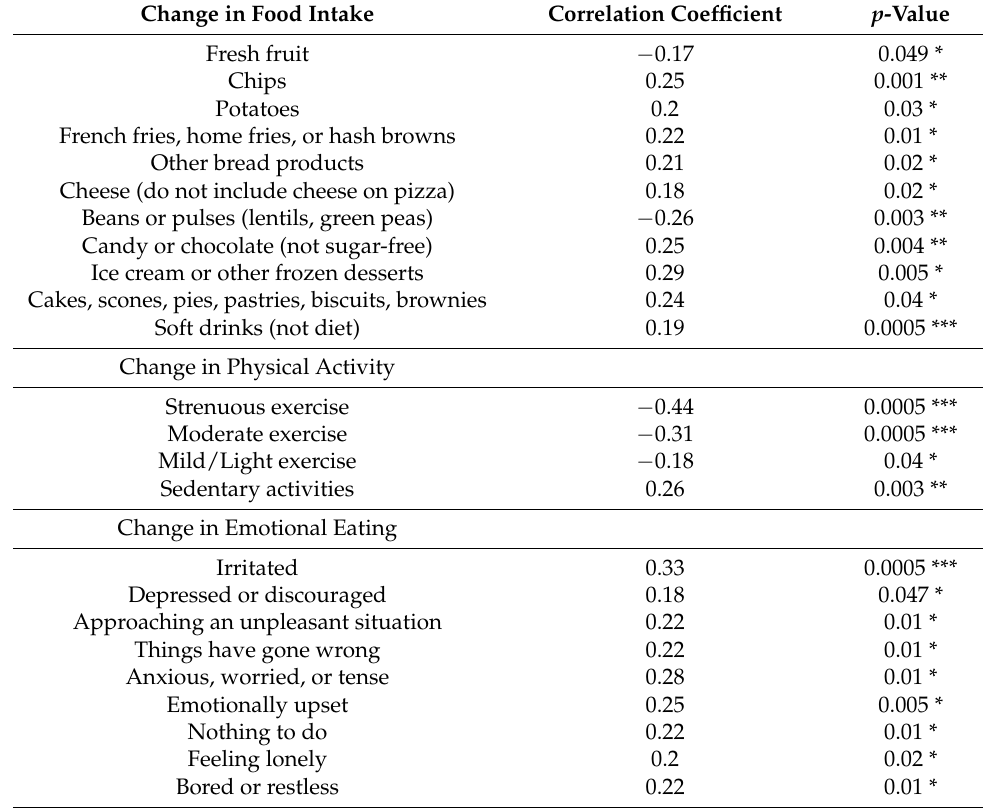
Table 2. Factors affecting weight gain. Spearman’s rank-order correlation test were used to measure